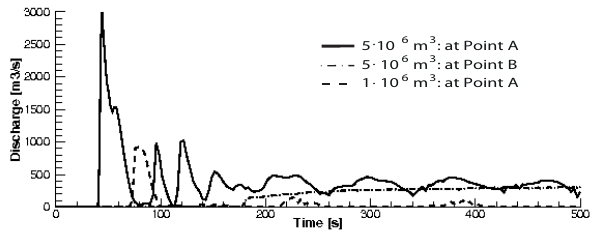
Fig. 13. Discharge in the canyon (position A) and 800m down- stream (position B) for ice release of 1 and 5 × 10 6 m 3